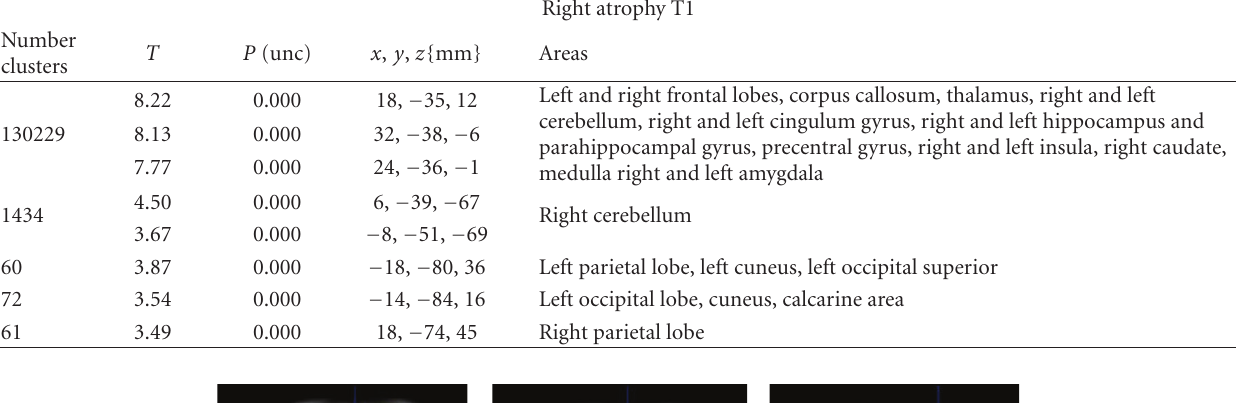
Table 4: Areas with WM atrophy on patients with right HA, from T1-weighted analysis.